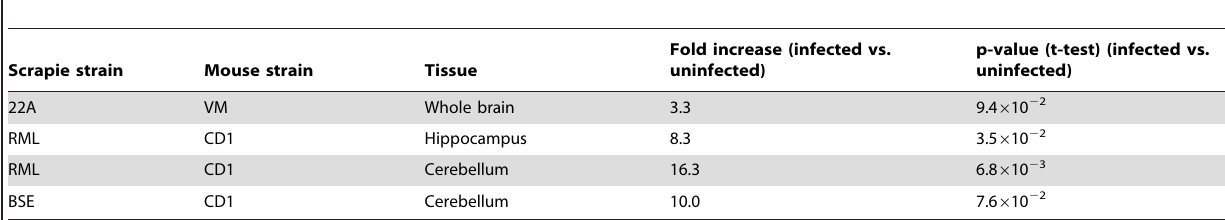
Table 1. Expression levels of miR-146a in brain tissue of mice infected with mouse-adapted scrapie or BSE as determined by quantitative RT-PCR (TaqMan H qRT-PCR) (relative quantitation was determined using the 2 2 DD Ct